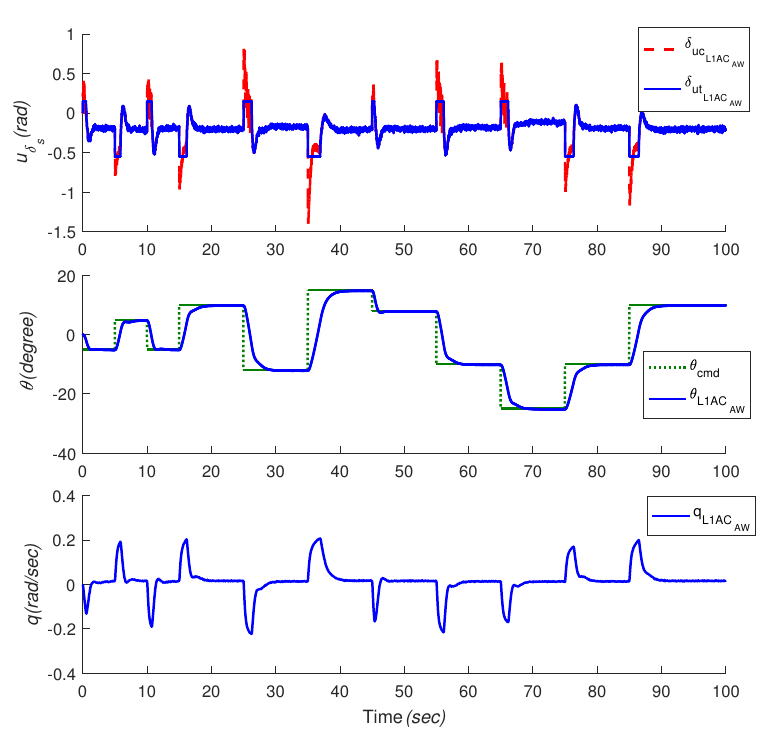
Figure 8. Pitch channel control in the presence of the actuator saturation for REMUS six DOF model tracking θ cmd with different set-points with measurement noise, elevator disturbance and input